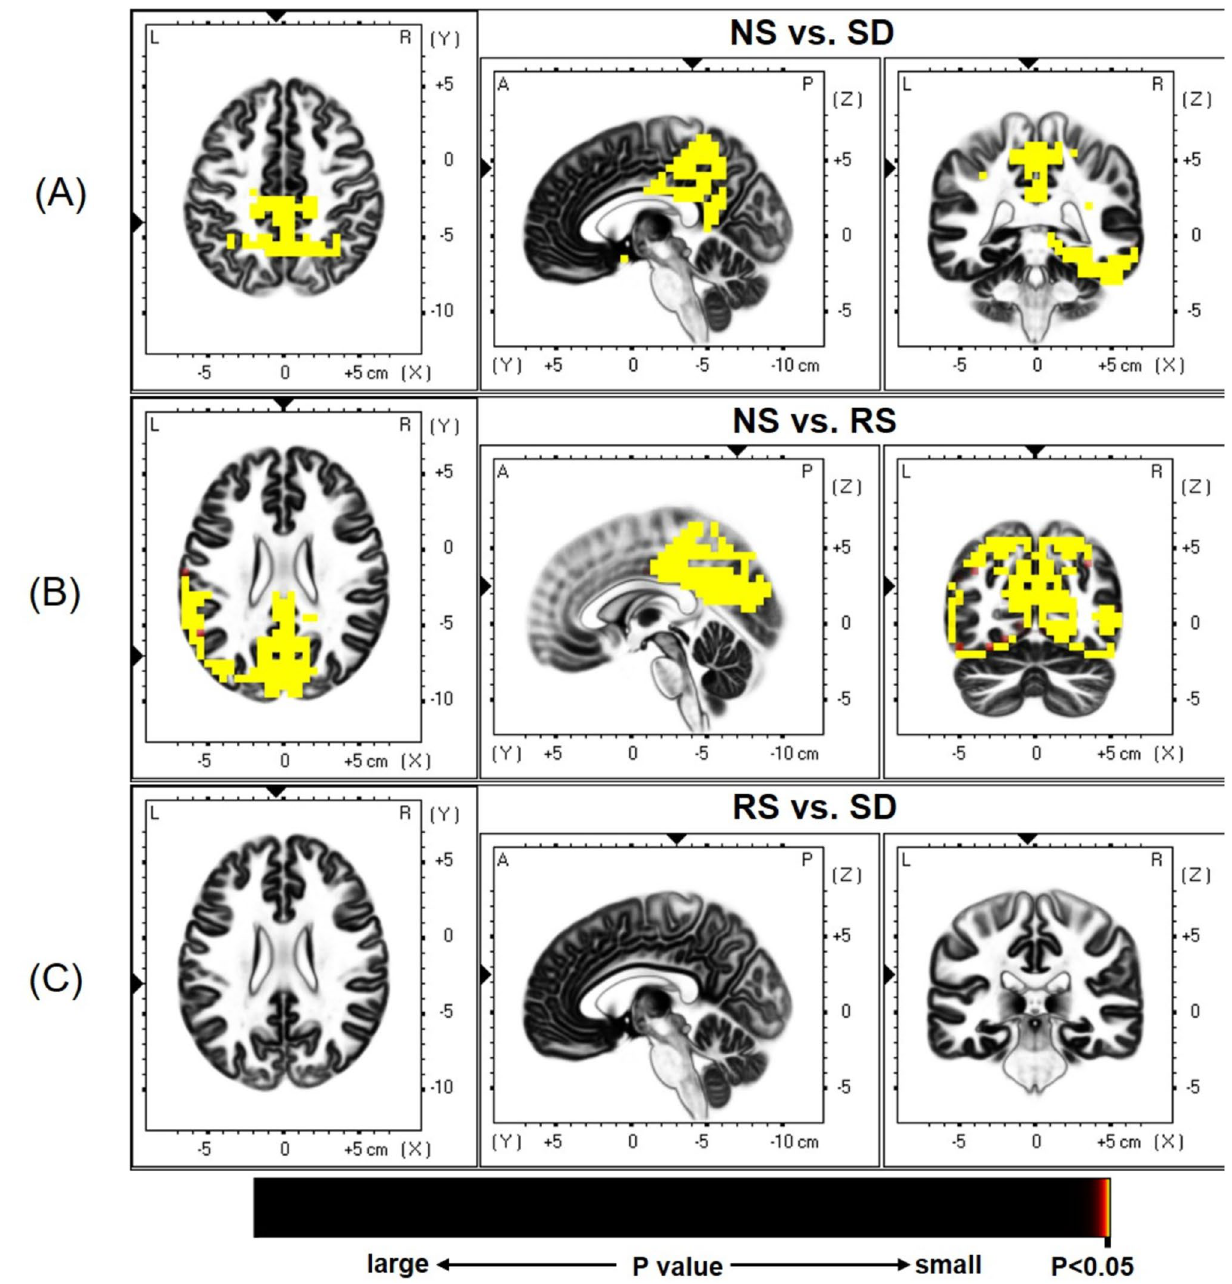
Figure 2. Differences in source activation between pairs of sessions. ( A ) NS session versus SD session; ( B ) NS session versus RS session; ( C ) RS session versus SD session. The significance level of activation contrast was set at p <